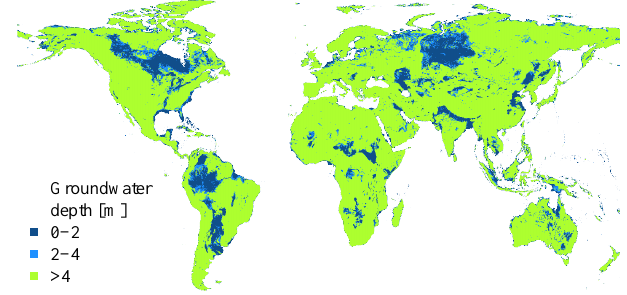
Figure 1. Locations with shallow groundwater (based on data from Fan et al., 2013). Lowland areas can be found all over the world and often in densely populated areas, which shows the relevance of WALRUS for application outside the